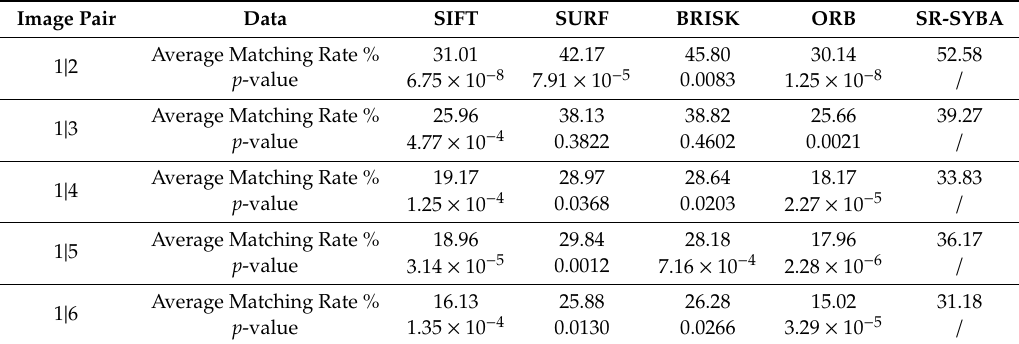
Table 4. Average matching rate and the p -values between SR-SYBA and other methods. Image Pair Data SIFT SURF BRISK